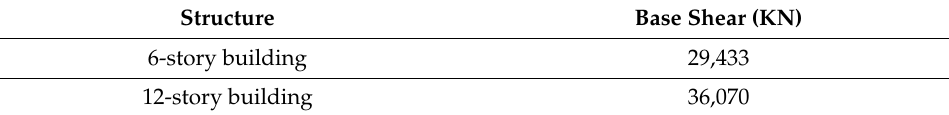
Table 9. Base shear from response spectrum.